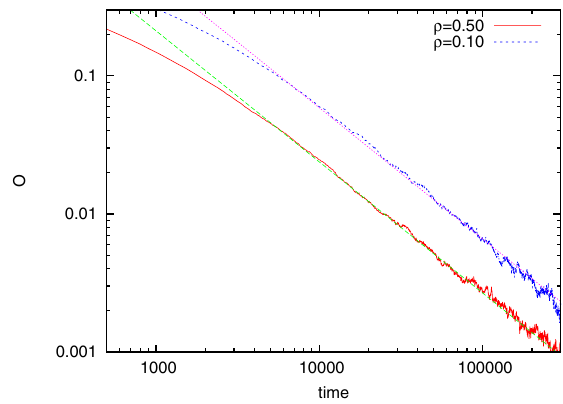
Fig. 3. Variation of average opinion with time at critical points for (cid:1) ¼ 0 : 50 and (cid:1) ¼ 0 : 10 . The value of (cid:5) is 0 : 95 (cid:5) 0 : 01 for both (cid:1) ¼ 0 : 50 and (cid:1) ¼ 0 : 10 .